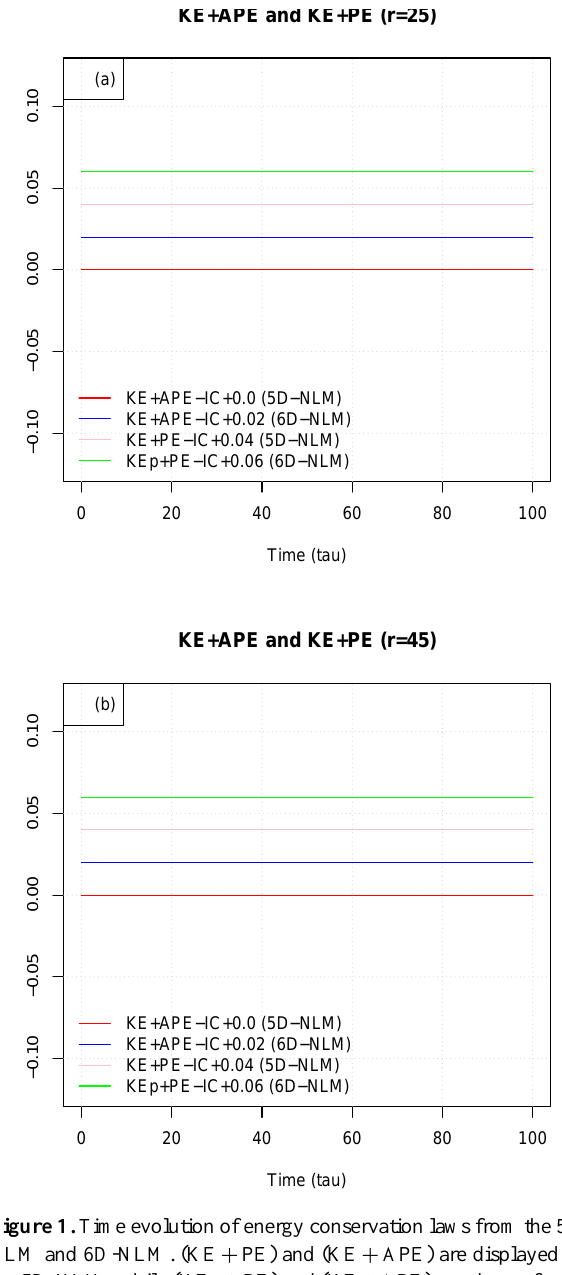
(cid:18) (cid:16) 1 + a 2 (cid:17) 3 (cid:19) = π 2 κ 2 , a